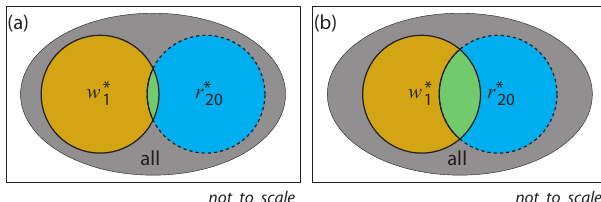
Fig. 9. Venn diagrams showing schematically the set of wind ex- tremes ( w ∗ , yellow) and 20 day precipitation extremes ( r ∗ , blue) 1 20 as subsets of the total data available (grey) and their overlap (green). By construction, both the w 1 ∗ and r ∗ subsets are 1% of all days. If 20 the wind extremes are independent of the precipitation extremes, the ) = probability of the joint event (green overlap) is P(w 1 ∗ )P(r ∗ 20 0 . 01 % of the total number of days, or equivalently, 1% of wind extremes occur by chance within the subset of precipitation ex- tremes (a) . However, ESSENCE data shows the percentage of joint events (green overlap) to be 2–4 times larger (b) , considering 20- day precipitation events. There are still, however, a large proportion of wind extremes ( b , yellow) that do not overlap with the set of extreme precipitation events. Fig. 10. Data density (kernel density estimation) for Rhine basin 20-day precipitation sums (DJF, 1950–1980) against the North Sea NNW wind component evaluated on the last of the 20 days. Labels indicate the proportion of the data cloud enclosed by the contours. Black contours are for the pure results from the ESSENCE data set. Grey contours show how the distribution would look if the two vari- ables were independent. Black (grey) shading is used where the true distribution’s frequency density exceeds (undercuts) that of the in- dependent distribution for the same NNW wind speed. Thin dashed lines show the 99% quantiles for each variable estimated from the pure data. The thick dashed line shows the 99% precipitation quan- tile of the sub group w ∗ satisfying w 1 > q w . The cross marks the 1 0 . 99 mean of the 2-D